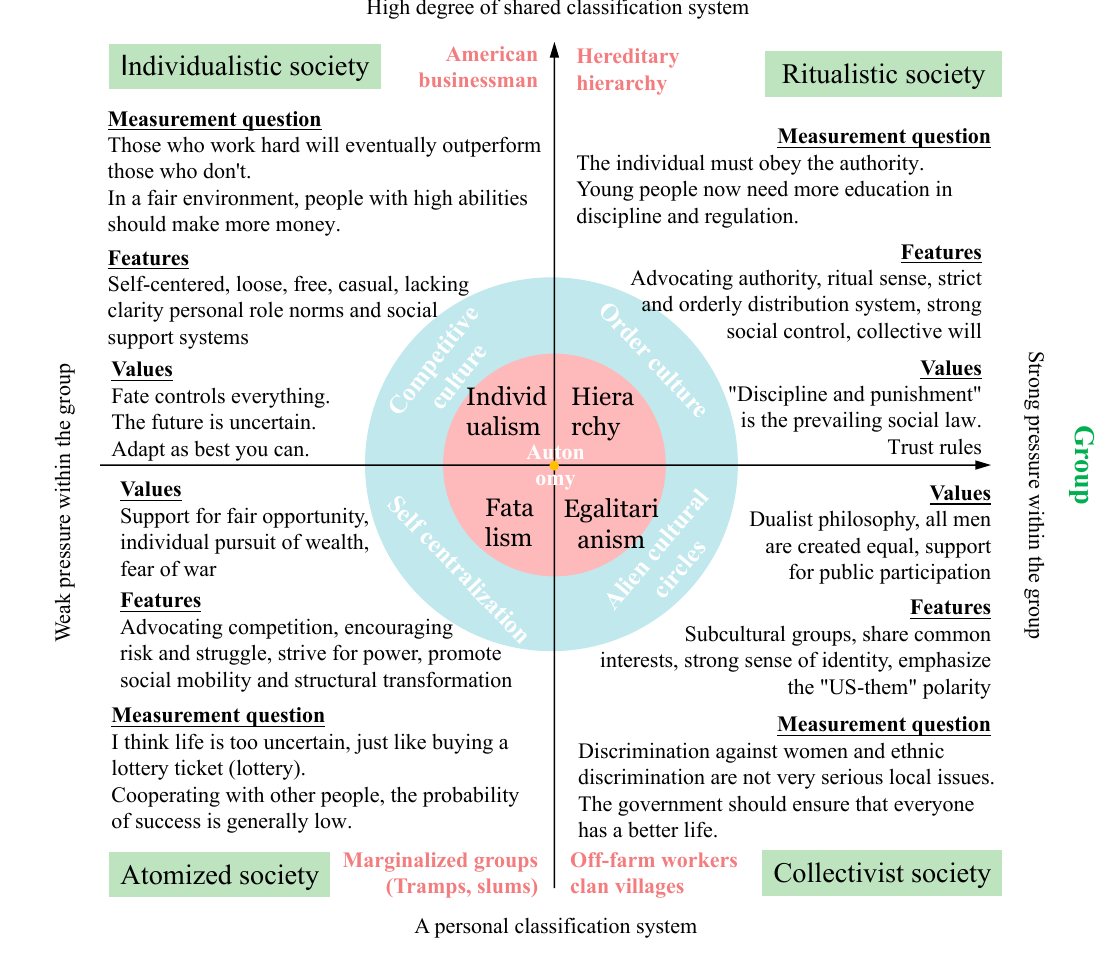
Figure 3. Classification matrix and determination of cultural types. This figure refers to the reference [13,15–18,20,21] in its drawing. The theoretical basis for this figure lies in Mary Douglas’s culture theory of the grid−group. The measurement question of each culture type is set up with reference to the literature [20,21].